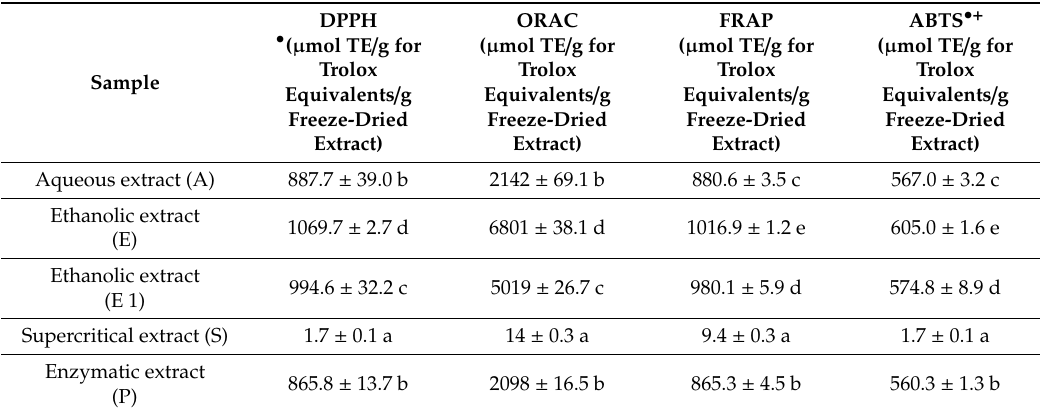
Table 1. Antiradical activity of freeze-dried